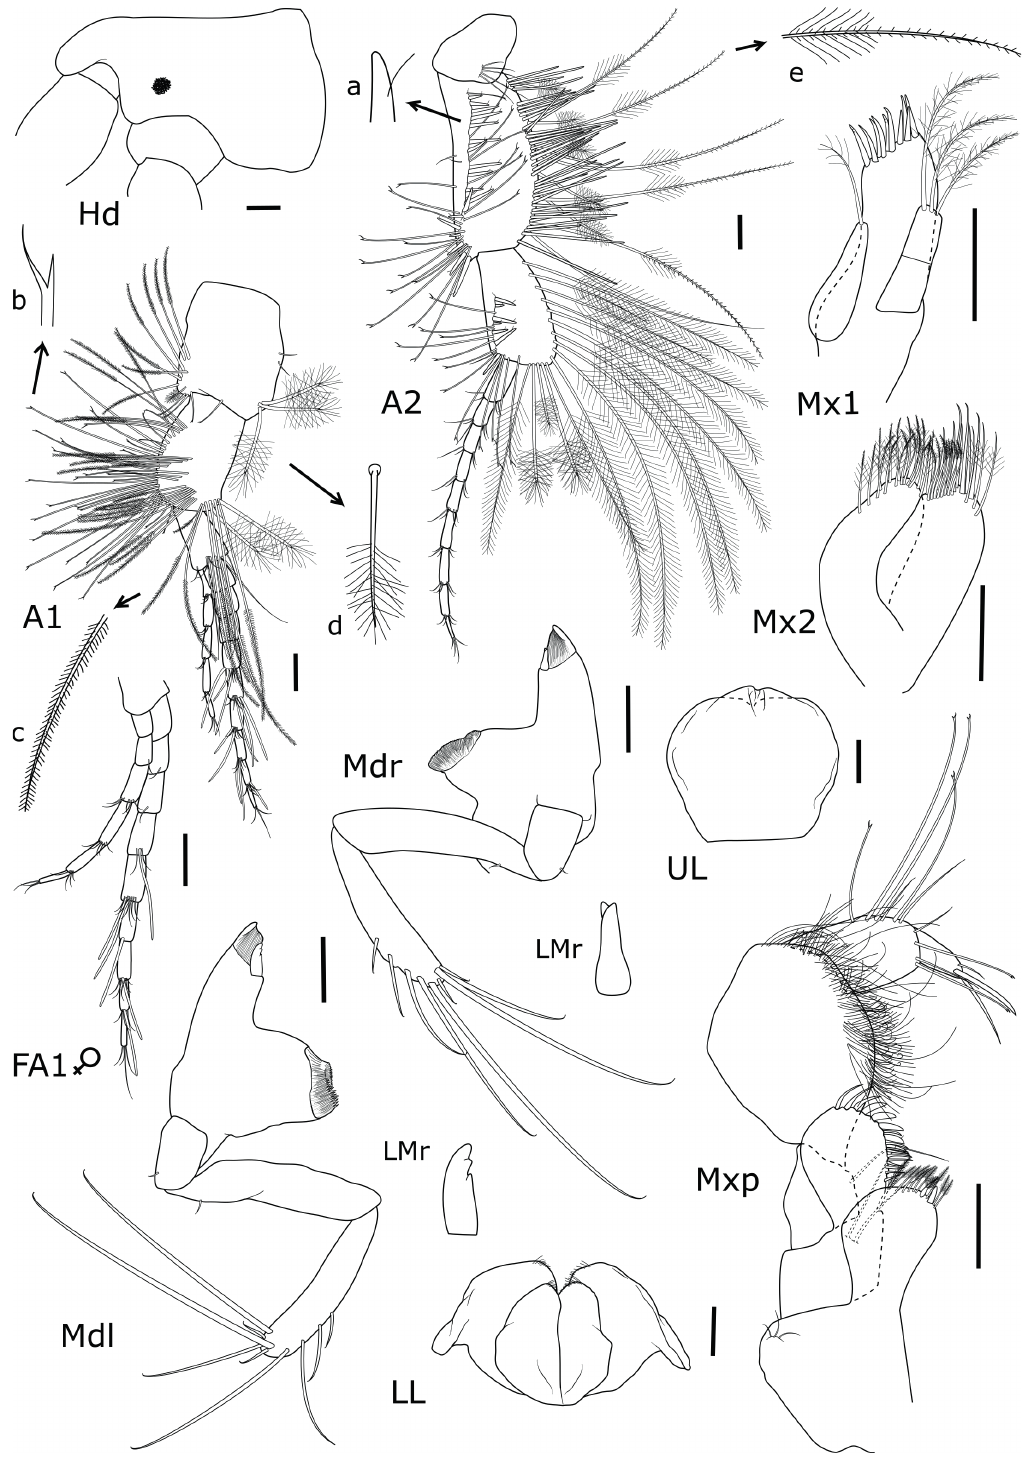
Figure 5 - Puelche irenae sp. nov. Male, 5.3 mm, MNRJ 28808: Head, antennas and mouthparts. Female, 4.5 mm, MNRJ 28809: Flagellum of antenna 1. Detailing of setae of antenna 1: a . robust seta with accessory seta; b . simple seta with lamellate tip; c . plumose seta with small setules; d . penicillate seta. Scales = 0.1